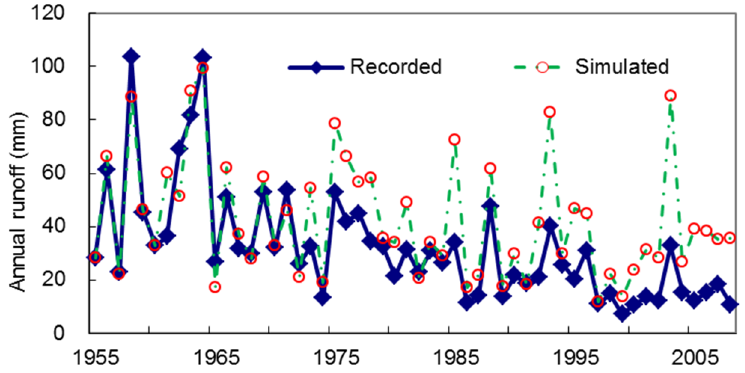
Figure 6. Annual recorded and simulated runoff at the Daning station for 1955–2008.